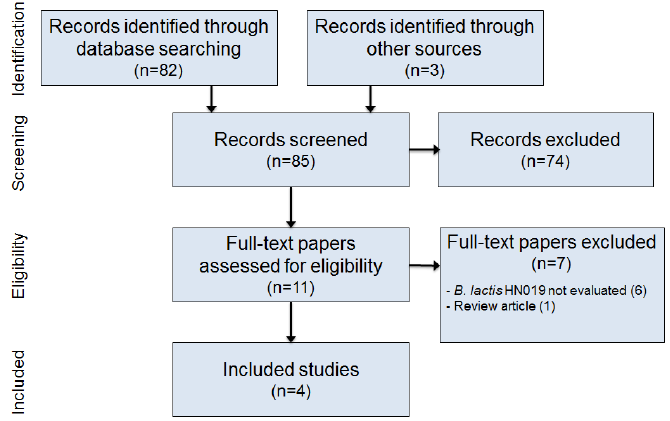
Figure 1. Preferred Reporting Items for Systematic Reviews and Meta ‐ Analyses (PRISMA) study flow diagram.